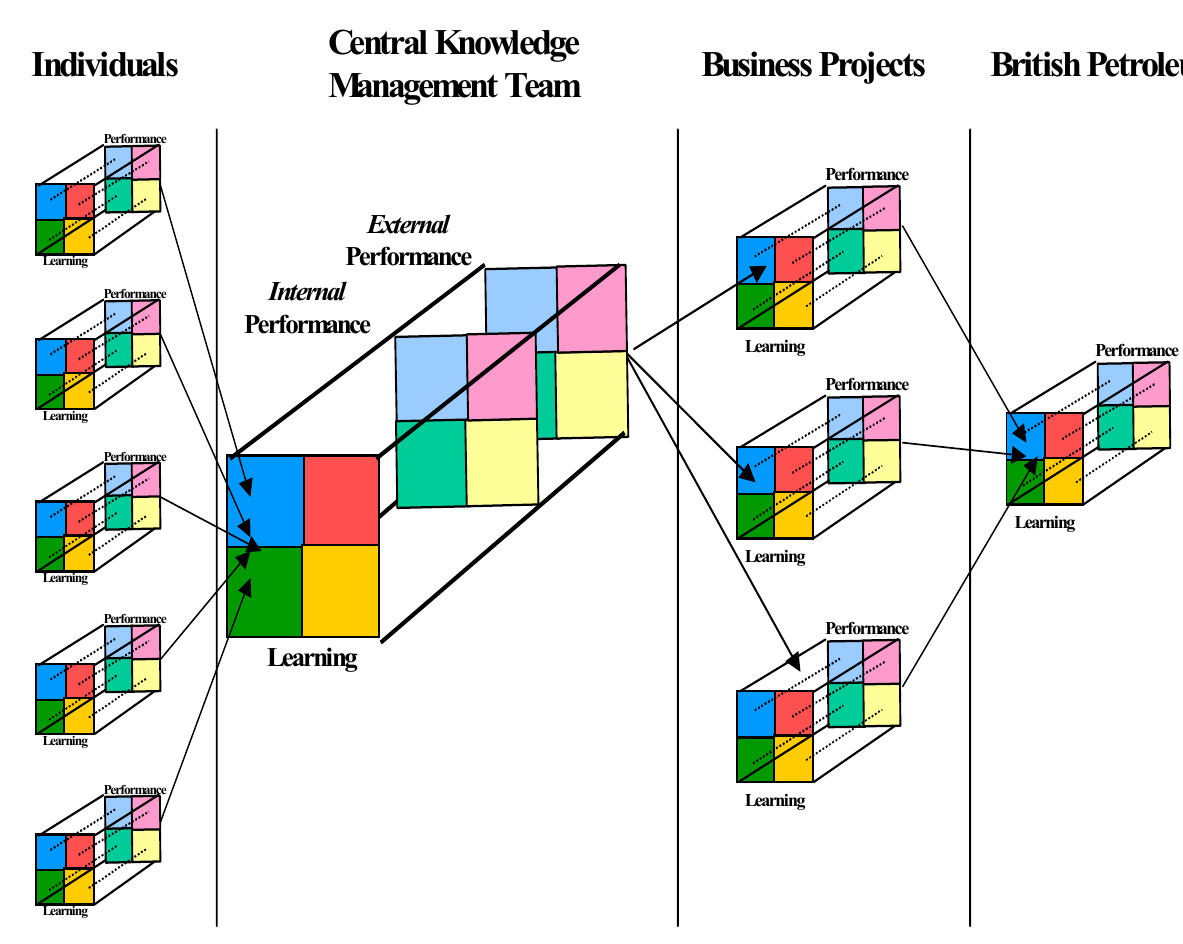
Figure 3: Performance through learning at four